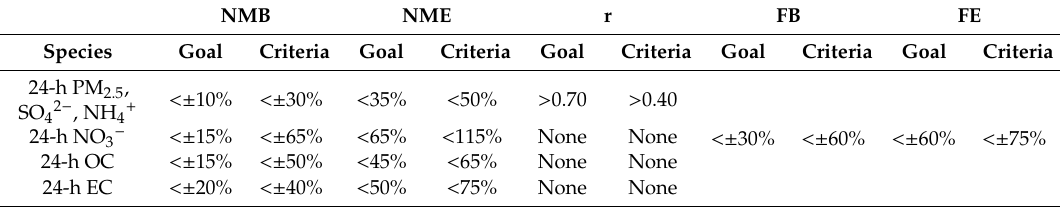
Table A1. Recommended benchmarks for photochemical model performance statistics